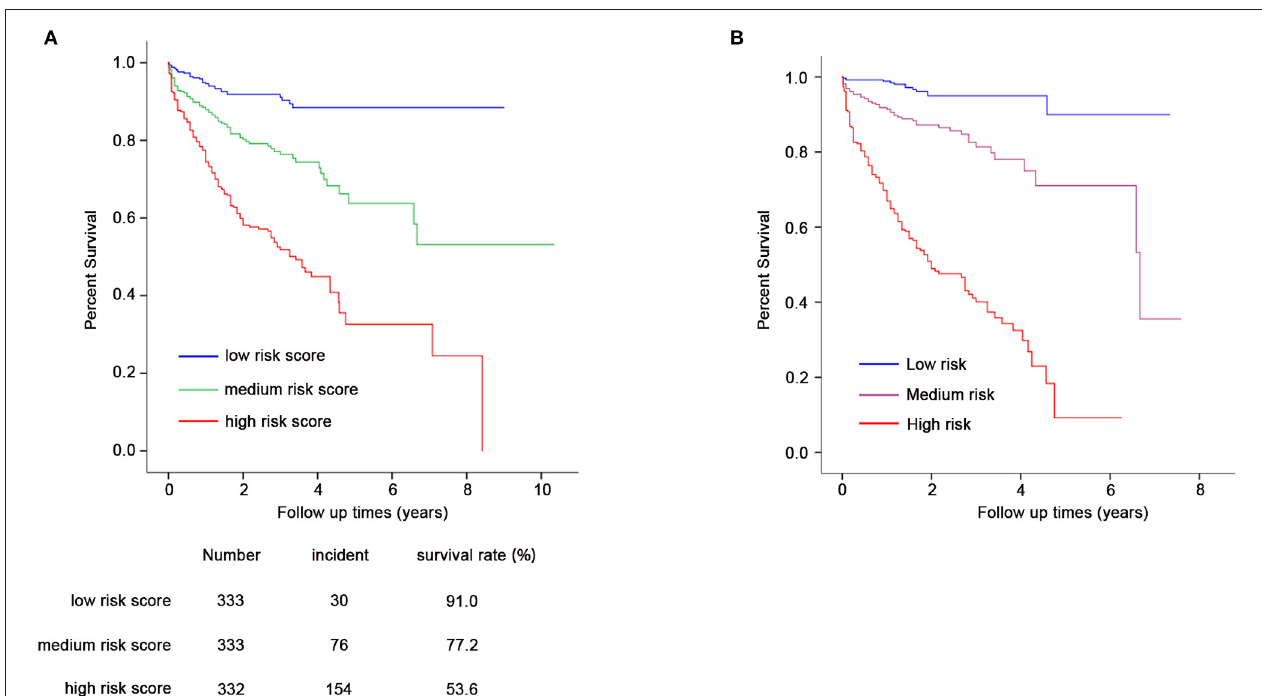
FIGURE 3 | Prognostic analysis for GRS and composite risk score (A,B) . Cox proportional hazards regression model was used for prognosis analysis. (A) Compared with the low-risk group ( N = 333), medium ( N = 333), and high-risk groups ( N = 332) showed increased HF-related mortality risk (HR = 2.78, 95% CI = 1.82–4.24, P = 2 × 10 − 6 for medium- vs. low-risk group; HR = 6.54, 95% CI = 4.42–9.71, P = 6 × 10 − 21 for high- vs. low-risk group). The statistical significance remains after adjustment for age, gender, hypertension, diabetes, hyperlipidemia, smoking status, and β -blocker use. (B) Composite risk score with medium and high risk showed significantly increased mortality risk of HF (HR = 5.41, 95% CI = 2.72–10.64, P = 1 × 10 − 6 for medium vs. low risk; HR = 22.72, 95% CI = 11.90–43.48, P = 5 × 10 − 21 for high vs. low risk).